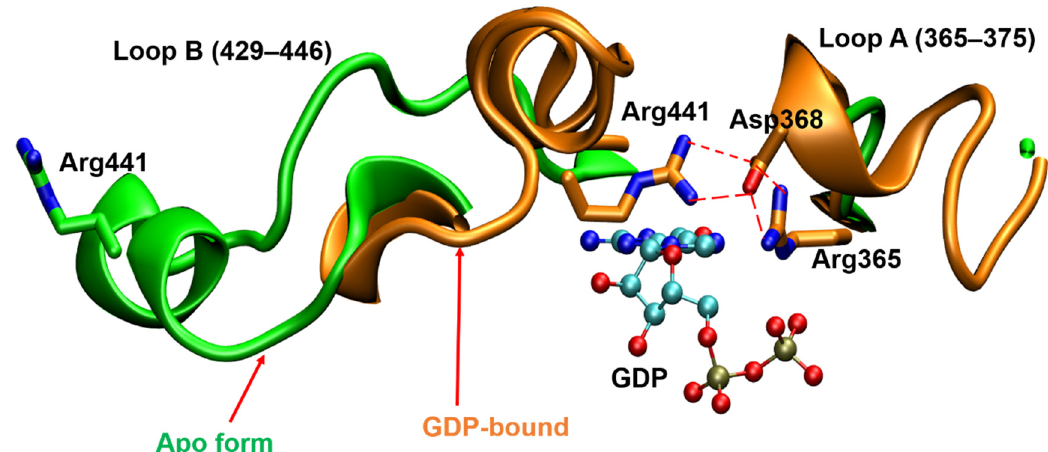
Figure 7. Superimposition of the GDP binding sites of apo form of Hs FUT8 (green, PDB ID:6VLE) and GDP-bound Mm FUT8 (brown, PDB ID:6VLG). The salt bridge interactions appear between Asp368 and Arg365/Arg441 from loops A and B, respectively, upon binding of GDP.